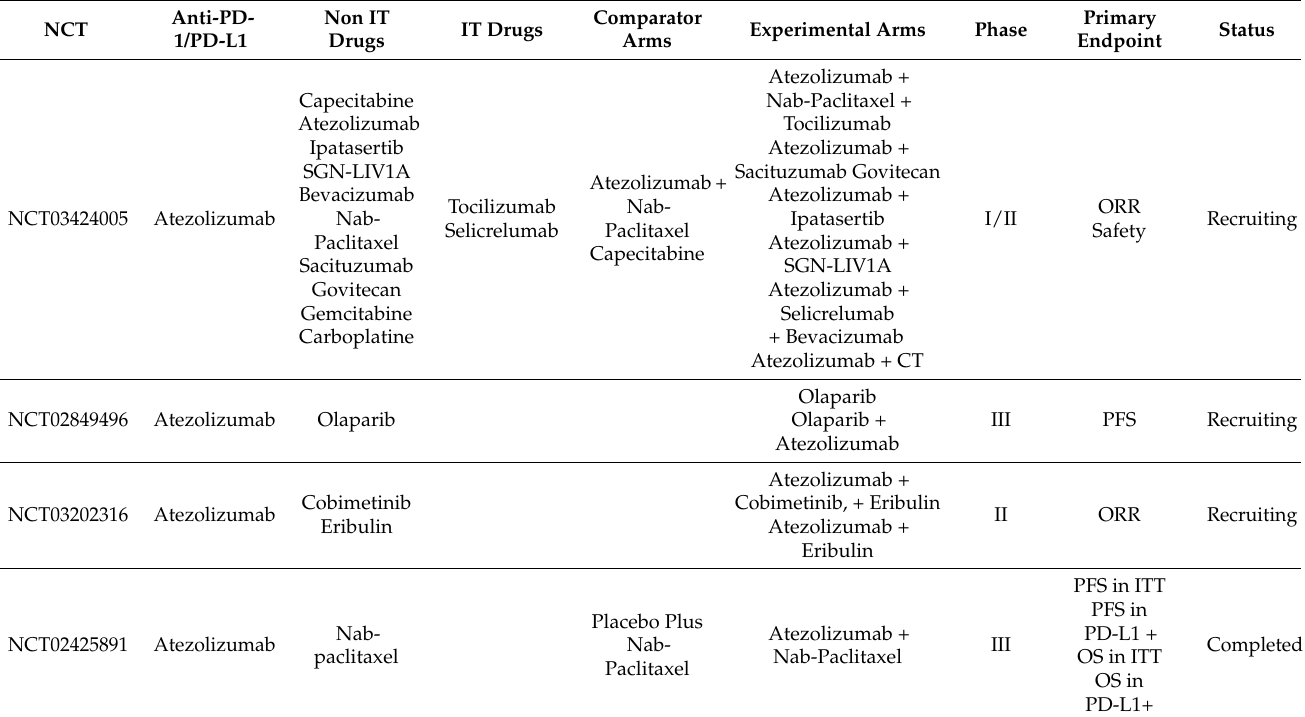
Table 1. List of completed or ongoing clinical trials with immune checkpoint inhibitors alone or with combinational drugs and novel immune-modulating strategies for mTNBC